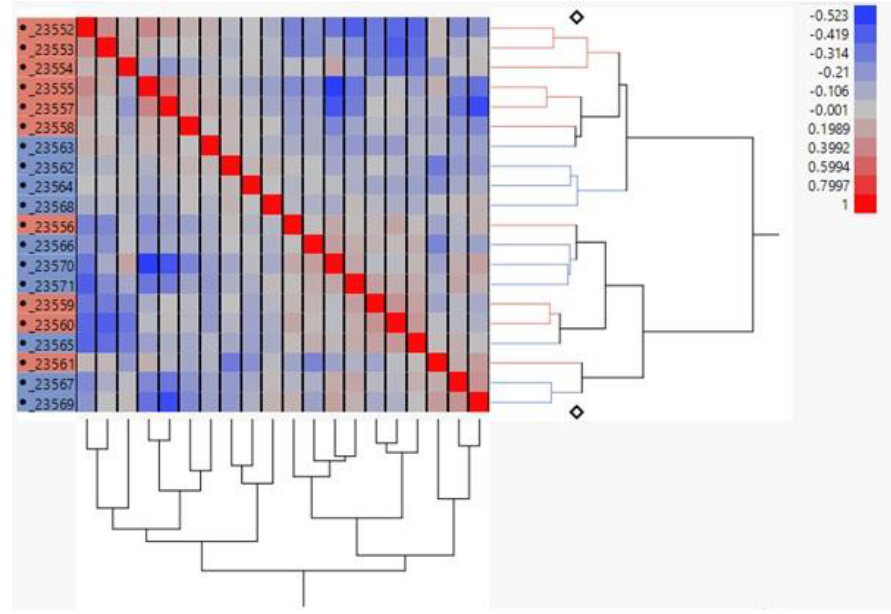
Figure 1. Correlation heat map of NGS-identified transcripts using upper quartile scaling normalization. The heat map represents the graphical display resulting from unsupervised clustering of the correlations between samples. The x - and y -axis are the same and the red diagonal line represents a correlation of 1. The pink labeled IDs are associated with the soybean diet while the blue labeled IDs are from the corn oil diet.